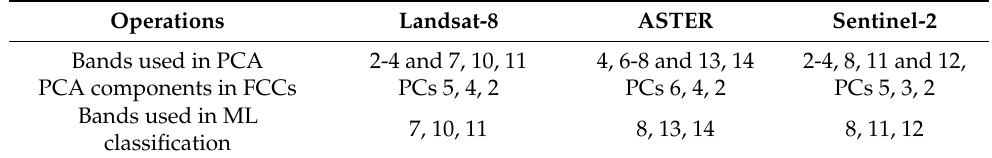
Table 1. Summary of bands used in PCA, machine-learning algorithms (MLAs), and components retained by Crosta techniques for RGB based false color composite